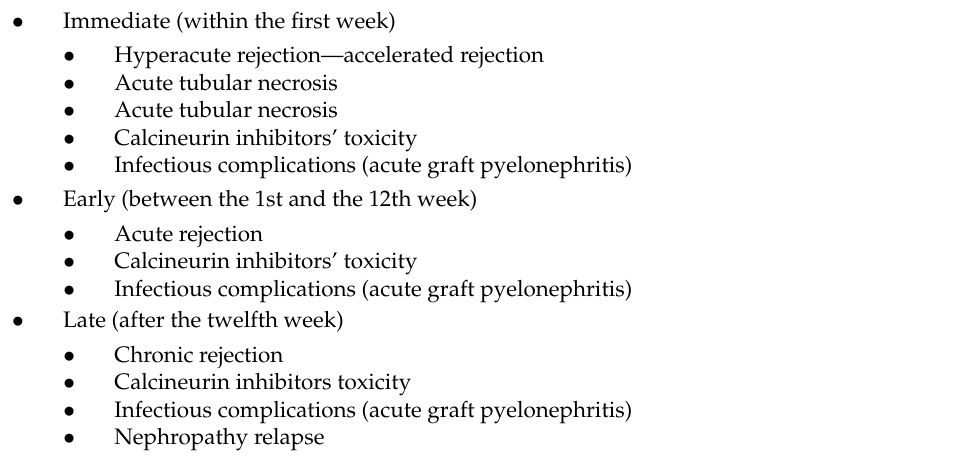
Table 1. Most common parenchymal complications in renal